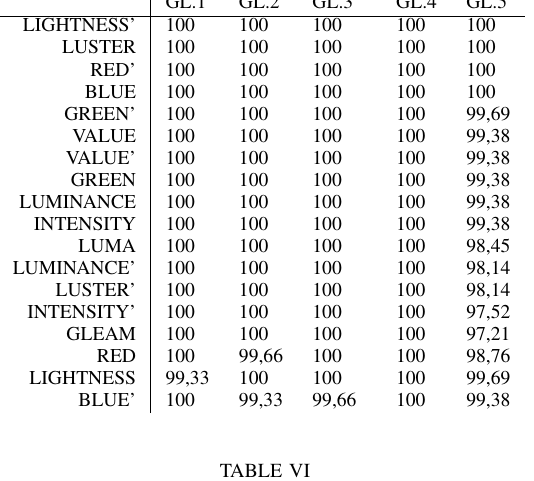
TABLE V T EMPLATE 3: % OF FRAMES WITH ENOUGH GOOD MATCHING Algorithm